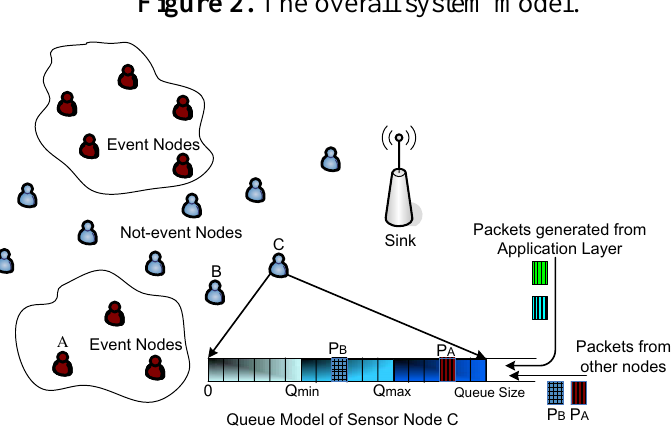
Figure 2. The overall system